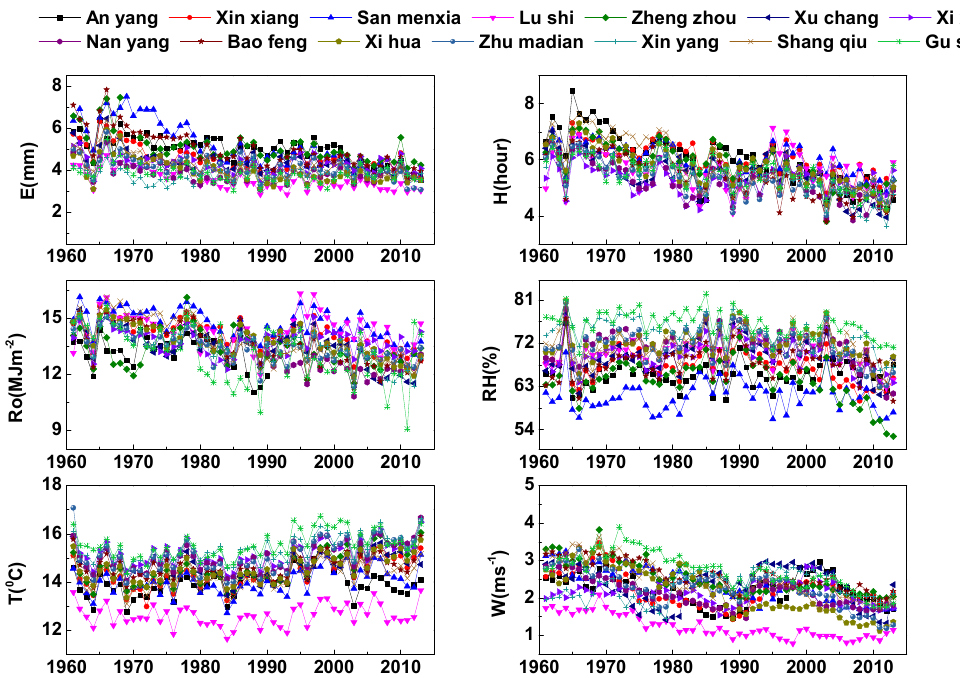
Figure 2. Annual variation trend of E and corresponding meteorological parameters of each station in Henan province.